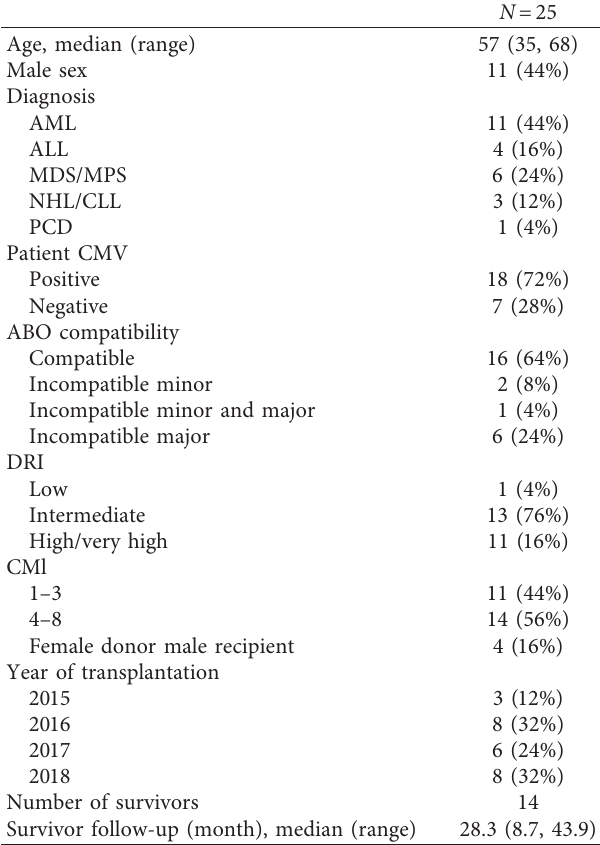
Table 1: Patients’ characteristics ( N �